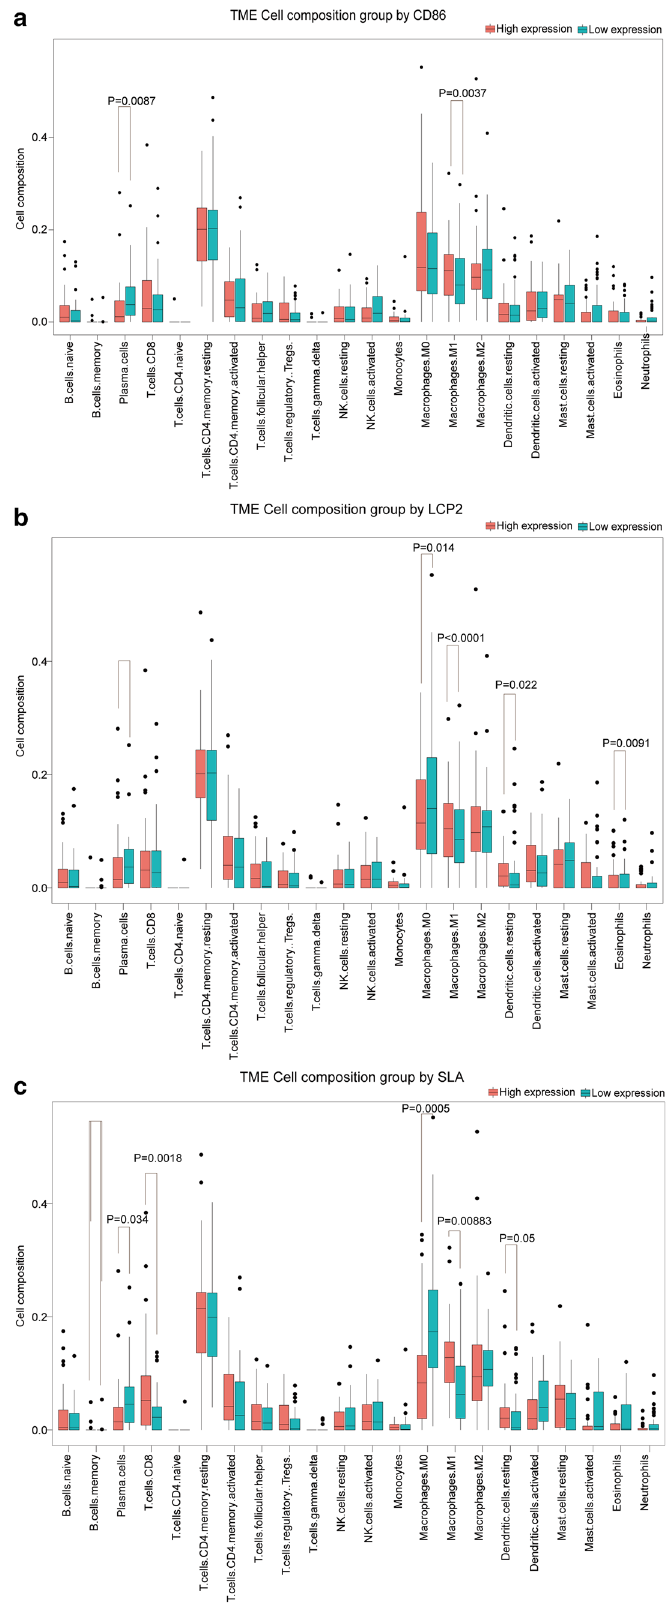
Fig. 11 Proportions of 22 subtypes of immune cells with high and low expression of core genes. a Boxplot of the proportion differentia- tion in immune cell subtypes between high and low CD86 expression groups for ESCC. b Boxplot of the proportion differentiation in immune cell subtypes between high and low LCP2 expression groups for ESCC. c Boxplot of the proportion differentia- tion in immune cell subtypes between high and low SLA expression groups for